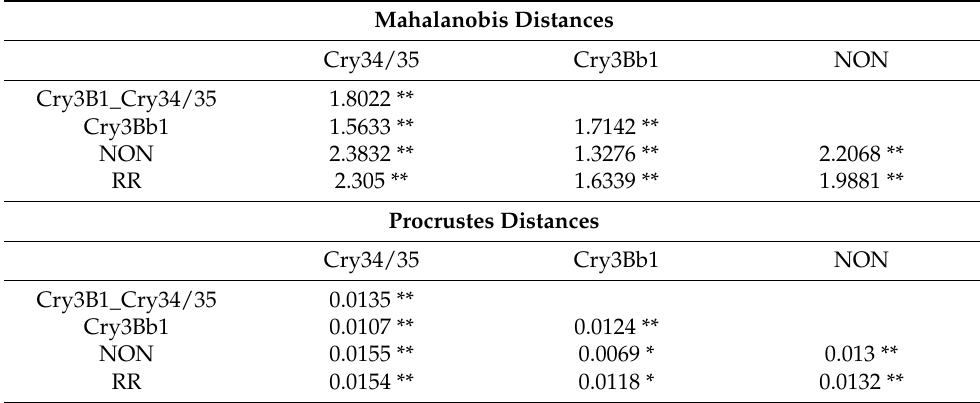
Table 5. Mahalanobis and Procrustes distances between groups obtained from canonical variate analysis. *: p < 0.05; **: p <